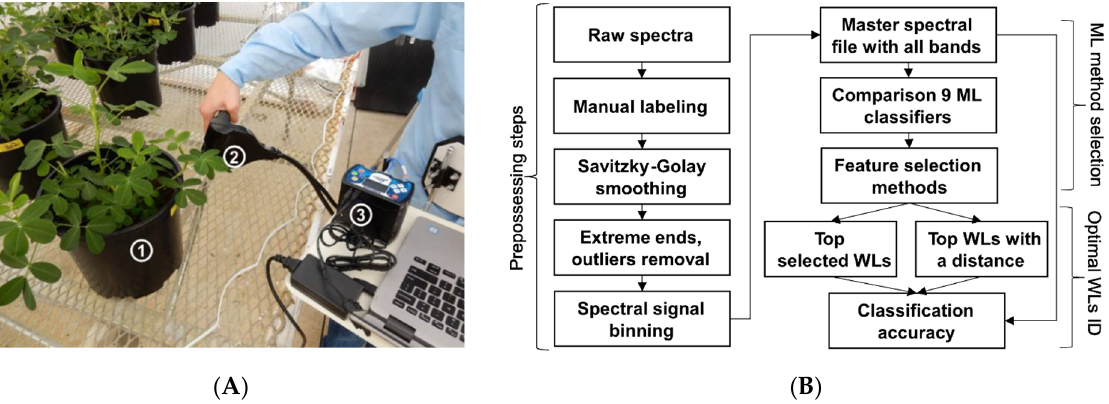
Figure 1. ( A ) Spectral reflectance measurement of peanut leaves with the Jaz spectrometer system: (1) individual potted peanut plant, (2) SpectroClip probe, (3) Jaz spectrometer. ( B ) Data analysis pipeline for the wavelength selection to classify healthy peanut plants and plants infected with Athelia rolfsii at different stages of disease development. ML = machine learning; WL = wavelengths; ID =